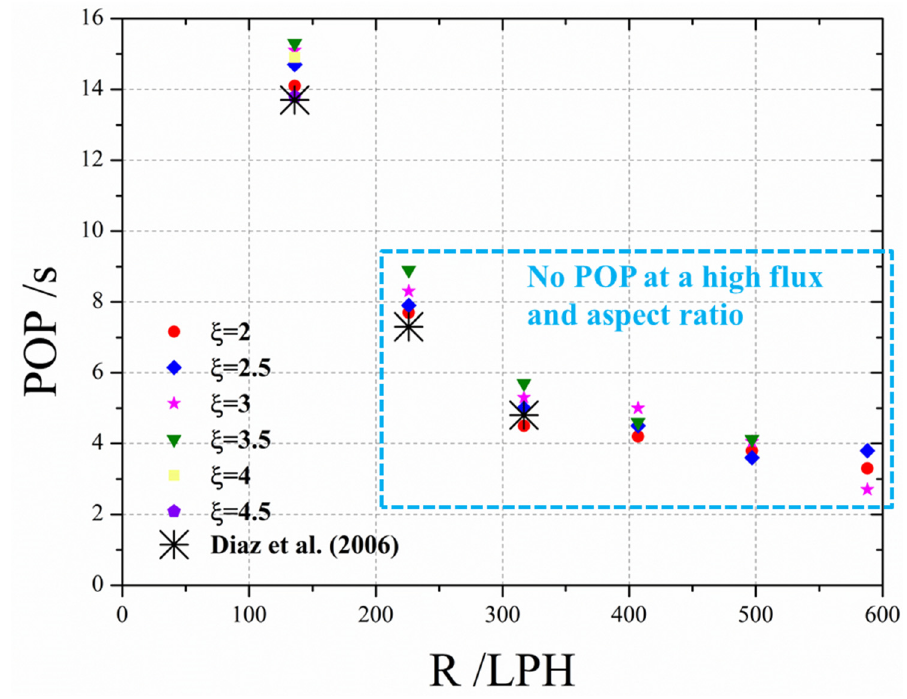
Figure 12. Plume oscillation period (POP) statistics under the different conditions.